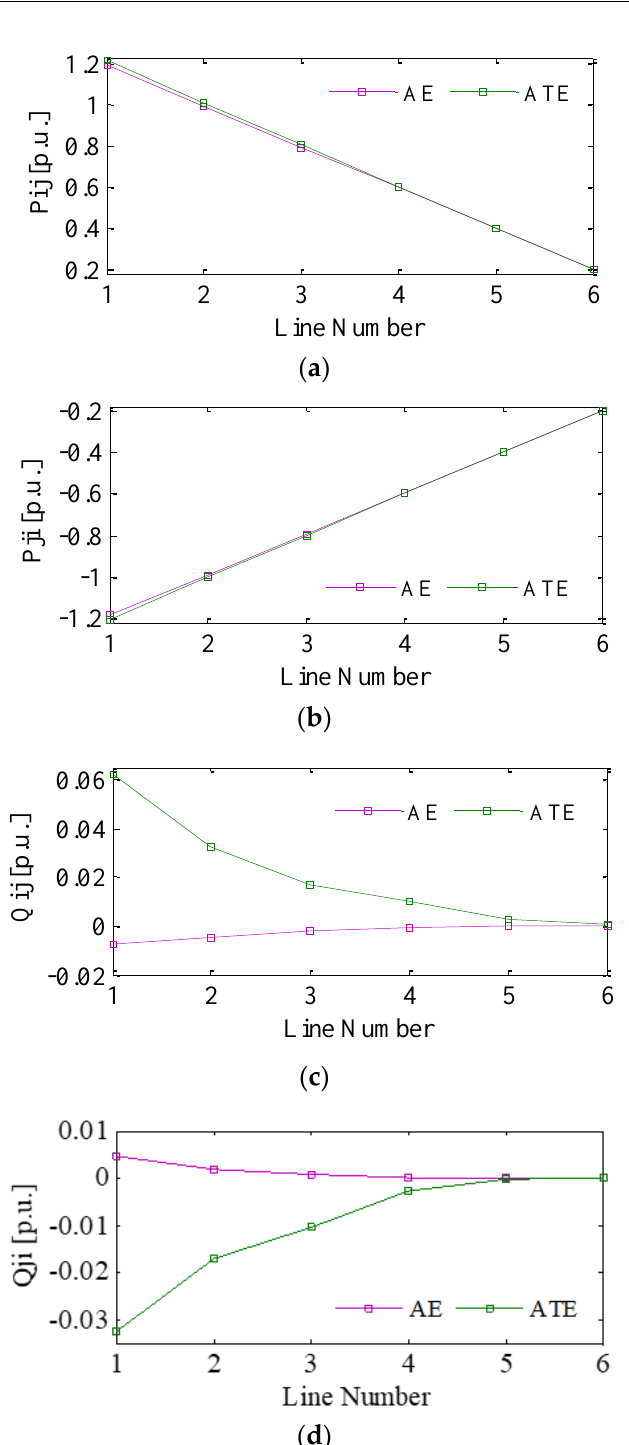
Figure 8. Line estimation ( a ) 𝑃 𝑖𝑗 ; ( b ) 𝑃 𝑗𝑖 ; ( c ) 𝑄 𝑖𝑗 ; ( d ) 𝑄 𝑗𝑖 using the conventional adaptive estimator and adaptive tolerant estimator.